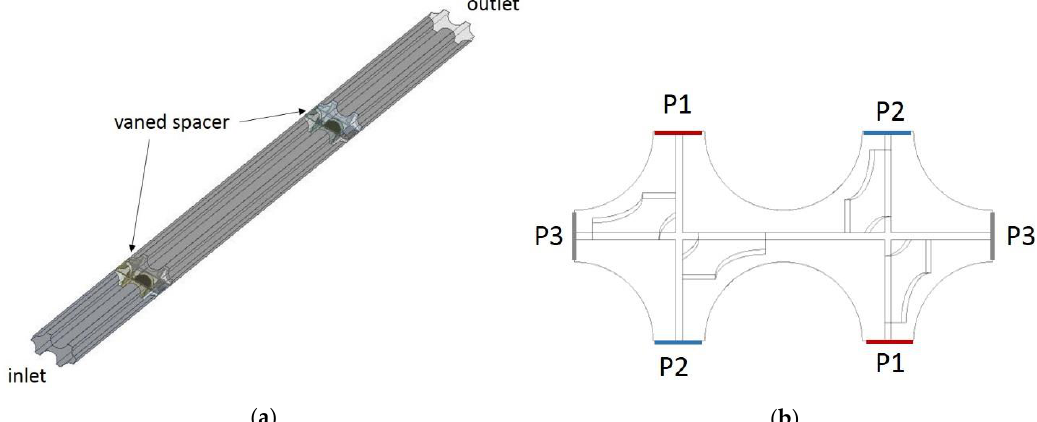
Figure 2. Computational domain of the two-channel model. ( a ) sketch for the computational domain; ( b ) sketch for periodic boundary conditions.